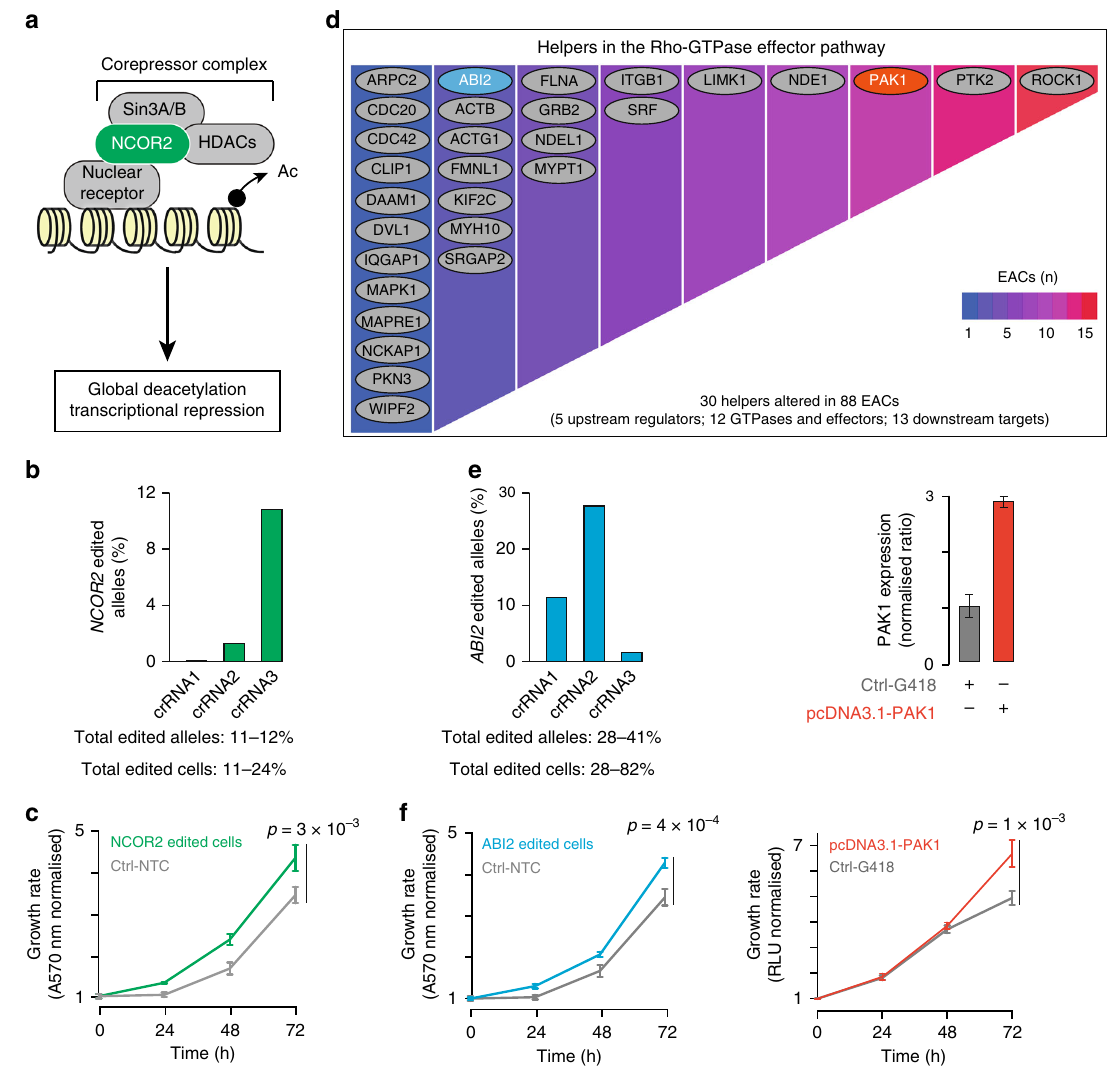
Fig. 5 Cancer helper role of selected genes. a Function of NCOR2 as part of the nuclear receptor co-repressor complex, whose activity results in chromatin deacetylation and transcriptional repression. b Editing of the NCOR2 gene using three pooled crRNAs where cells are transiently co-transfected with Cas9 protein, crRNAs and tracrRNA 32 . The editing ef fi ciency was measured using MiSeq. For NCOR2 two regions were sequenced, one containing the region targeted by crRNA1 and 2 and the other the region targeted bycrRNA3. For ABI2 only one amplicon was sequenced, containing the region targeted by all three crRNAs. The range of edited alleles and edited cells was derived considering the two opposite scenarios where all three crRNAs edit the same alleles/ cells or different alleles/cells, respectively. c Proliferation curve of NCOR2 or non-targeting control (NTC) edited FLO-1 cells. d Manual curation of the helpers contributing to the Rho-GTPase effectors pathway. Heatmap indicates the number of samples with alterations in each gene. ABI2 (blue) and PAK1 (red) were selected for experimental validation. e Induced alterations in ABI2 and PAK1 genes. Editing of ABI2 was performed and assessed as described for NCOR2 . PAK1 mRNA expression in FLO-1 cells was assessed by qRT-PCR, relativised to β -2-microglobulin and normalised to control cells. Experiments were done in triplicate in n = 2 biological replicates. f Proliferation curves of FLO-1 cells after ABI2 editing or PAK1 overexpression. For all proliferation assays, n = 3 biological replicates were performed, each with four technical replicates. Proliferation was assessed every 24 h and each time point was normalised to time zero. Mean values at 72 h were compared by two-tailed Student ’ s t -test. All error bars show standard deviation. Source data are available in the Source Data fi